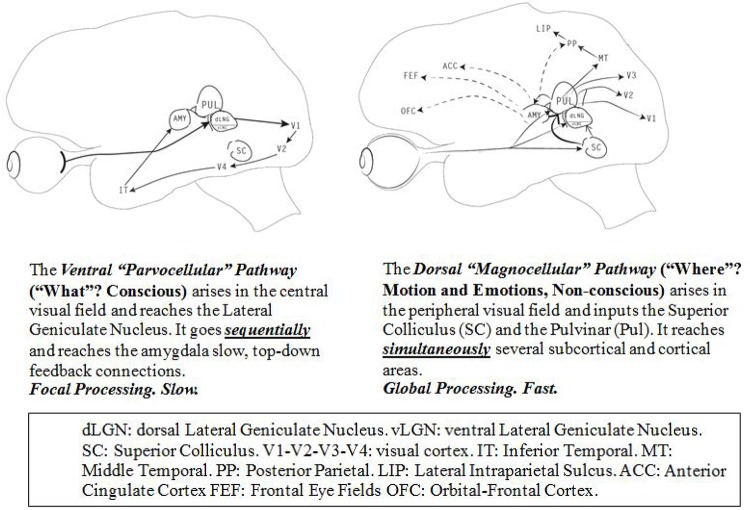
Two visual pathways.